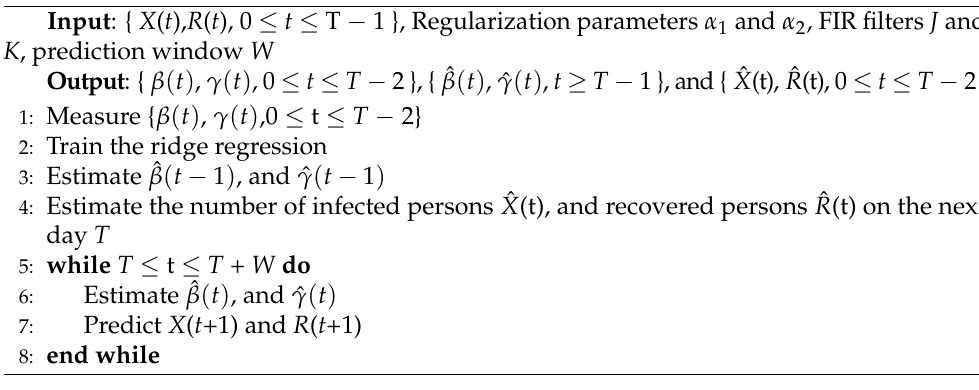
Algorithm A1 : Time-Dependent SIR Model.